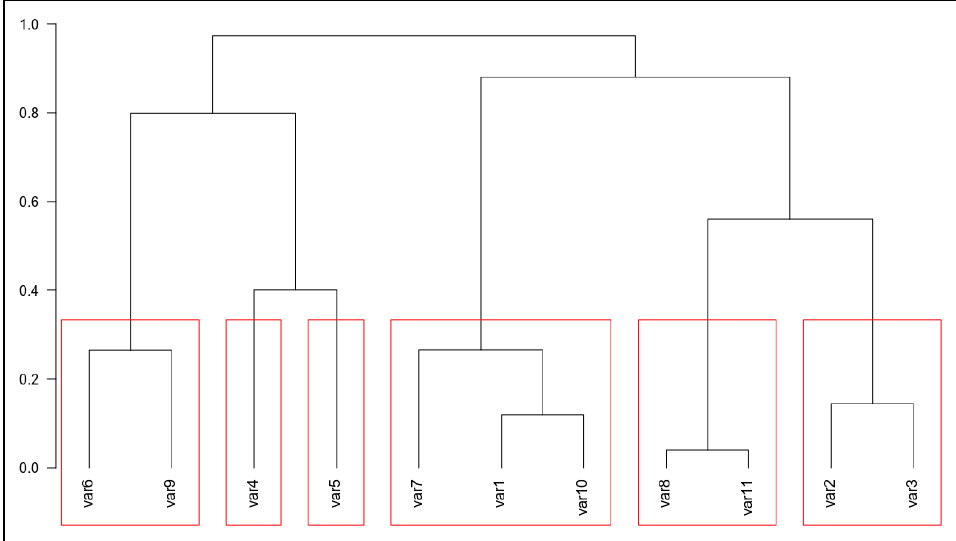
Figure 2. Groups of intercorrelated variables from the WorldClim v.2 dataset at cutoff 0.7; the y -axis represents distances between groups (1-Spearman's r). Variables (var): var1—annual mean temperature, var2—annual precipitation, var4—precipitation driest month, var5—precipitation seasonality, var9—max. temperature of the warmest month, var11—temperature annual range. Discarded variables: var3—precipitation of wettest month, var6—mean diurnal range, var7—isothermality, var8—temperature seasonality, var10—min. temperature of the coldest month.